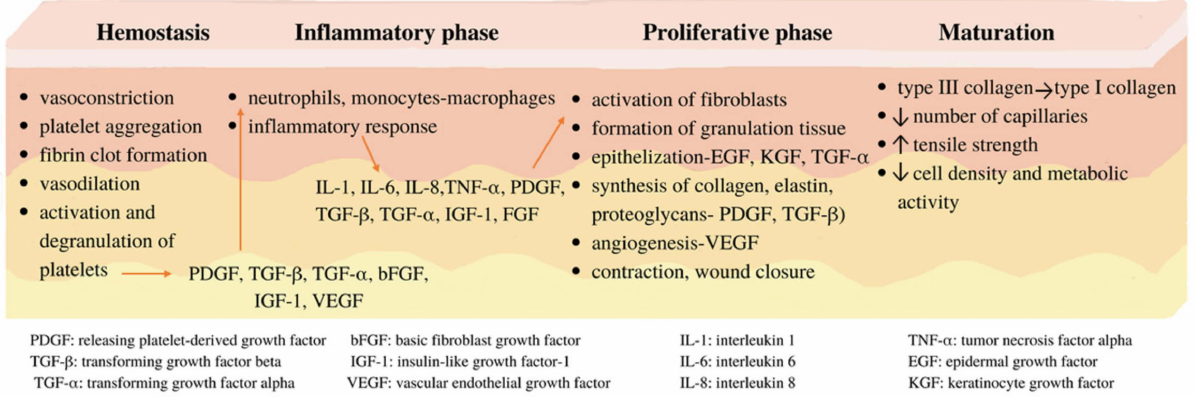
Figure 1. The main stages of the wound-healing